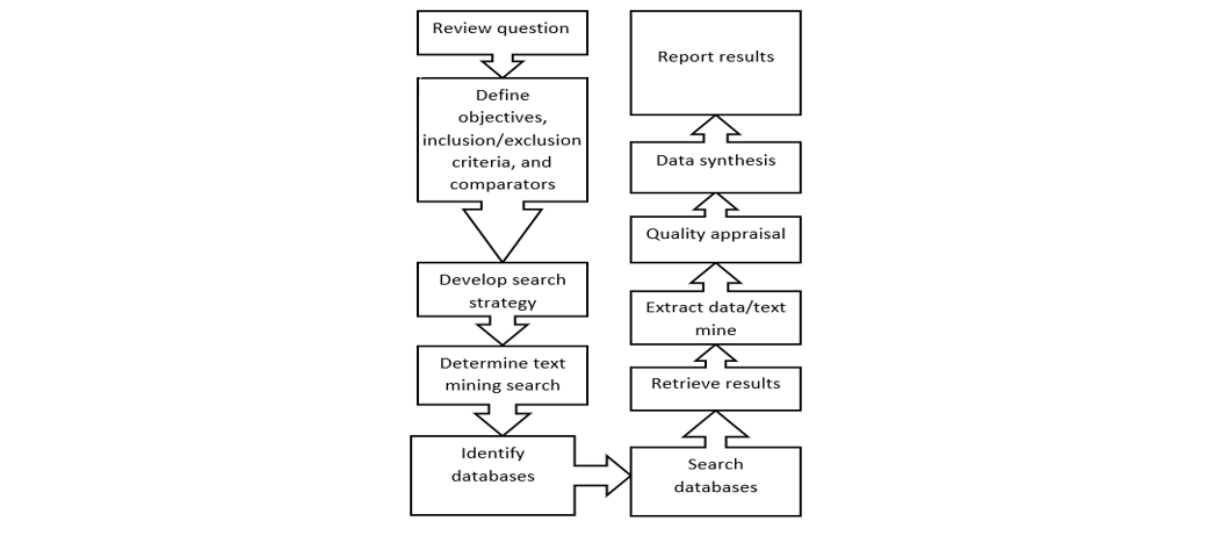
Figure 2. Stages of the systematic